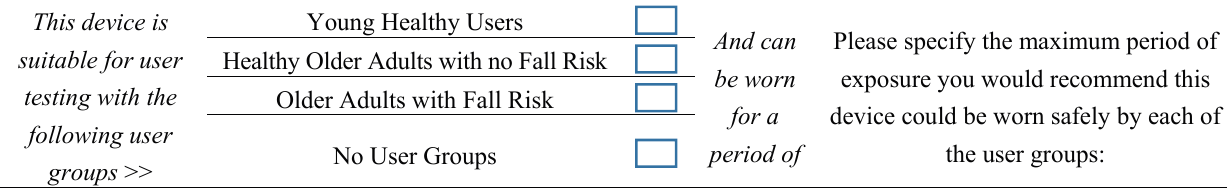
Table 4. Simple questionnaire for experts to provide recommendations for the user testing